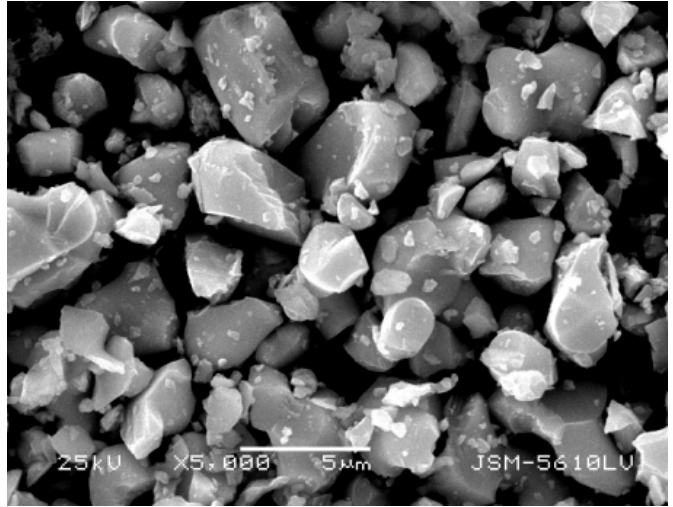
Figure 13. SEM photograph of REOs.